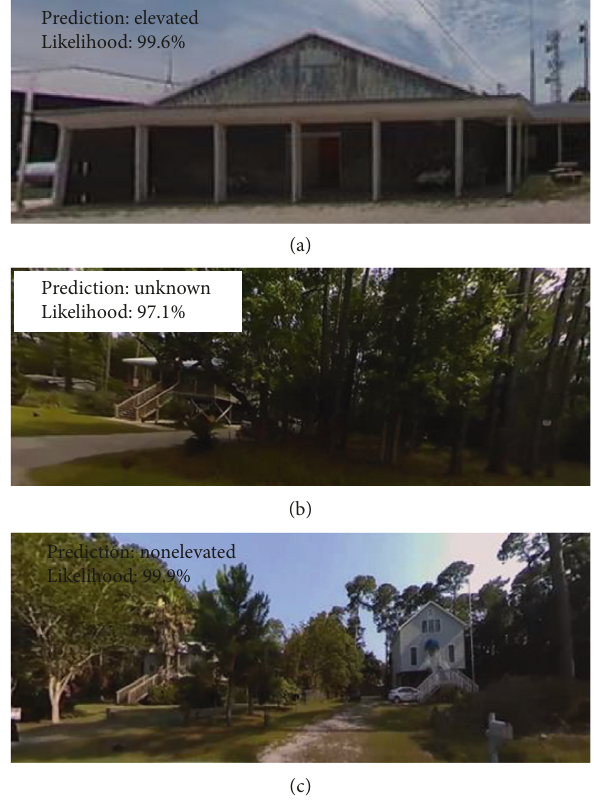
Figure 9: Incorrectly predicted images of buildings on Dauphin Island with class predictions of (a) elevated, (b) unknown, and (c) nonelevated structures.